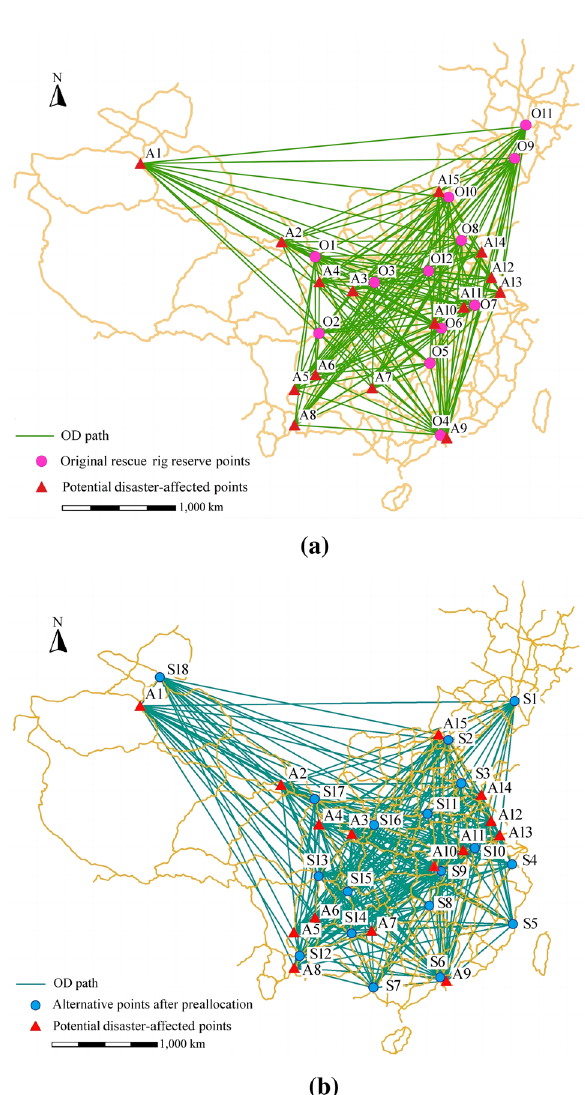
Fig. 4 Origin-destination (OD) solution process between original reserve points and potential disaster-affected points ( a ); and OD solu- tion process between alternative points and potential disaster-affected points ( b